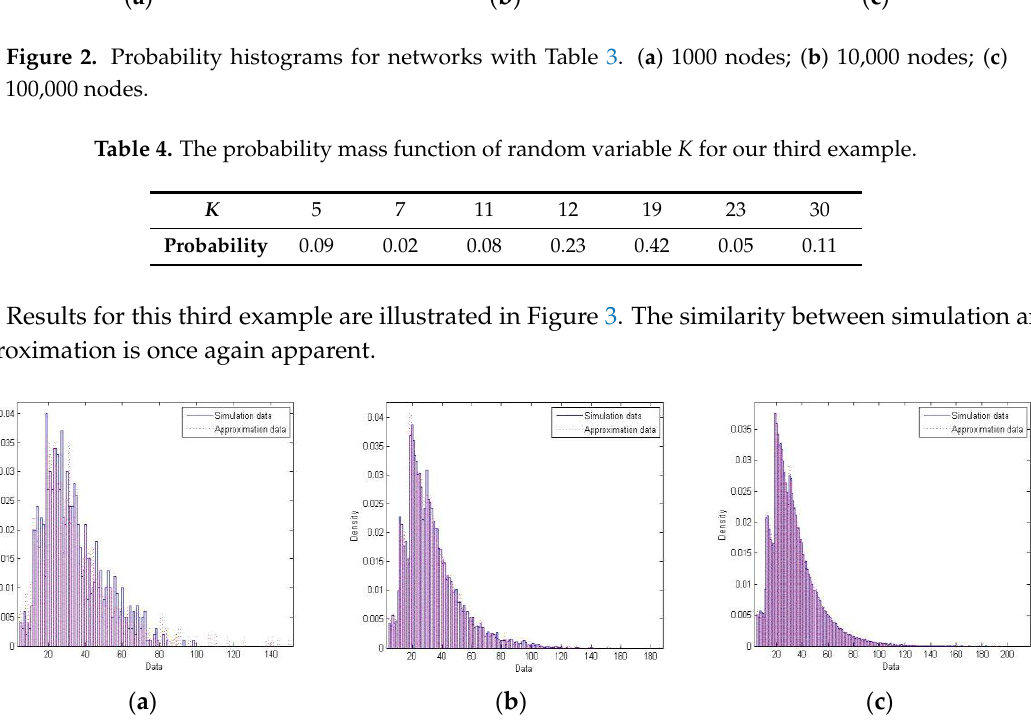
Figure 3. Probability histograms for networks with Table 4. ( a ) 1000 nodes; ( b ) 10,000 nodes; ( c ) 100,000 nodes.